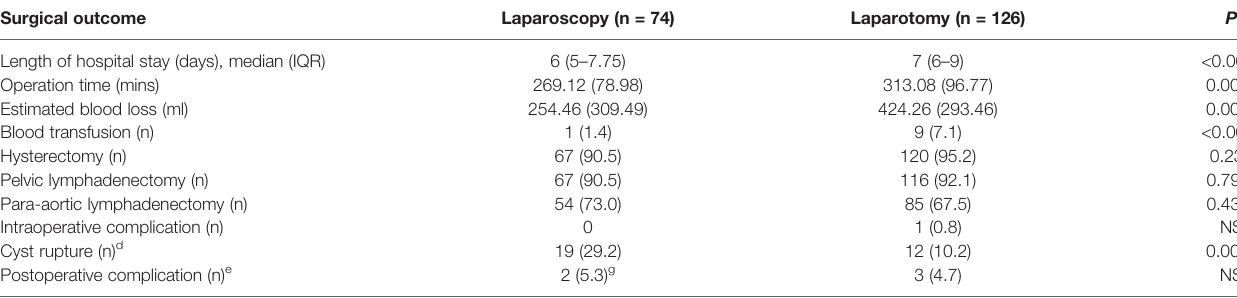
TABLE 2 | Operative outcomes by surgery approach in propensity score-matched cohort. Surgical